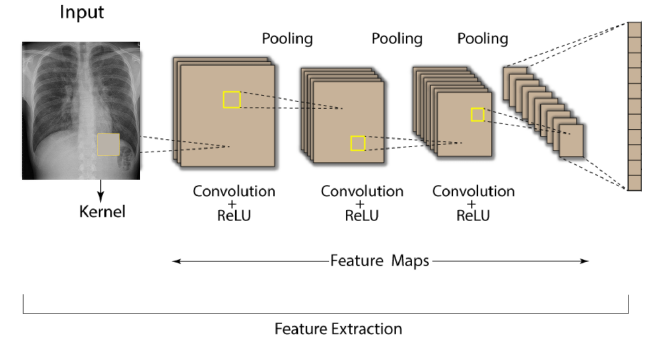
Figure 2. Feature maps phase.